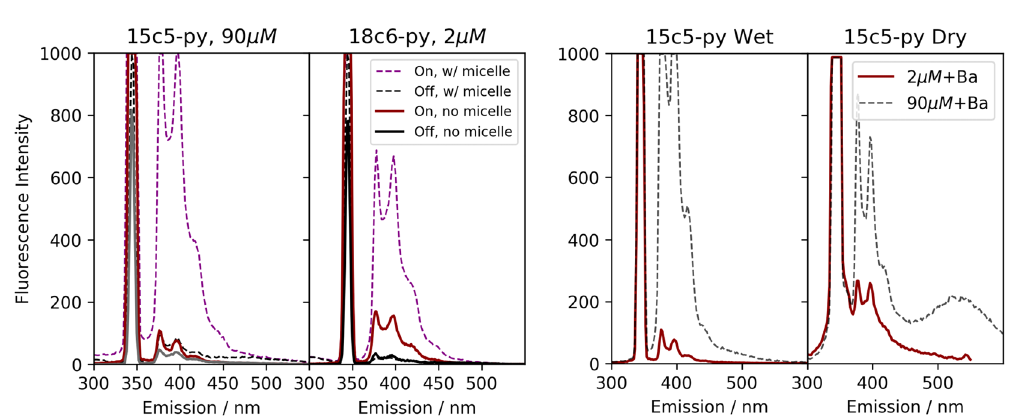
Figure 5. Left: Effect of micelles on 15c5-py and 18c6-py species, showing significant solvent effect on fluorescence in wet state. Right: effect of increasing 15c5-py concentration. A direct increase in primary fluorescence is observed in solution, whereas an excimer peak emerges in dry